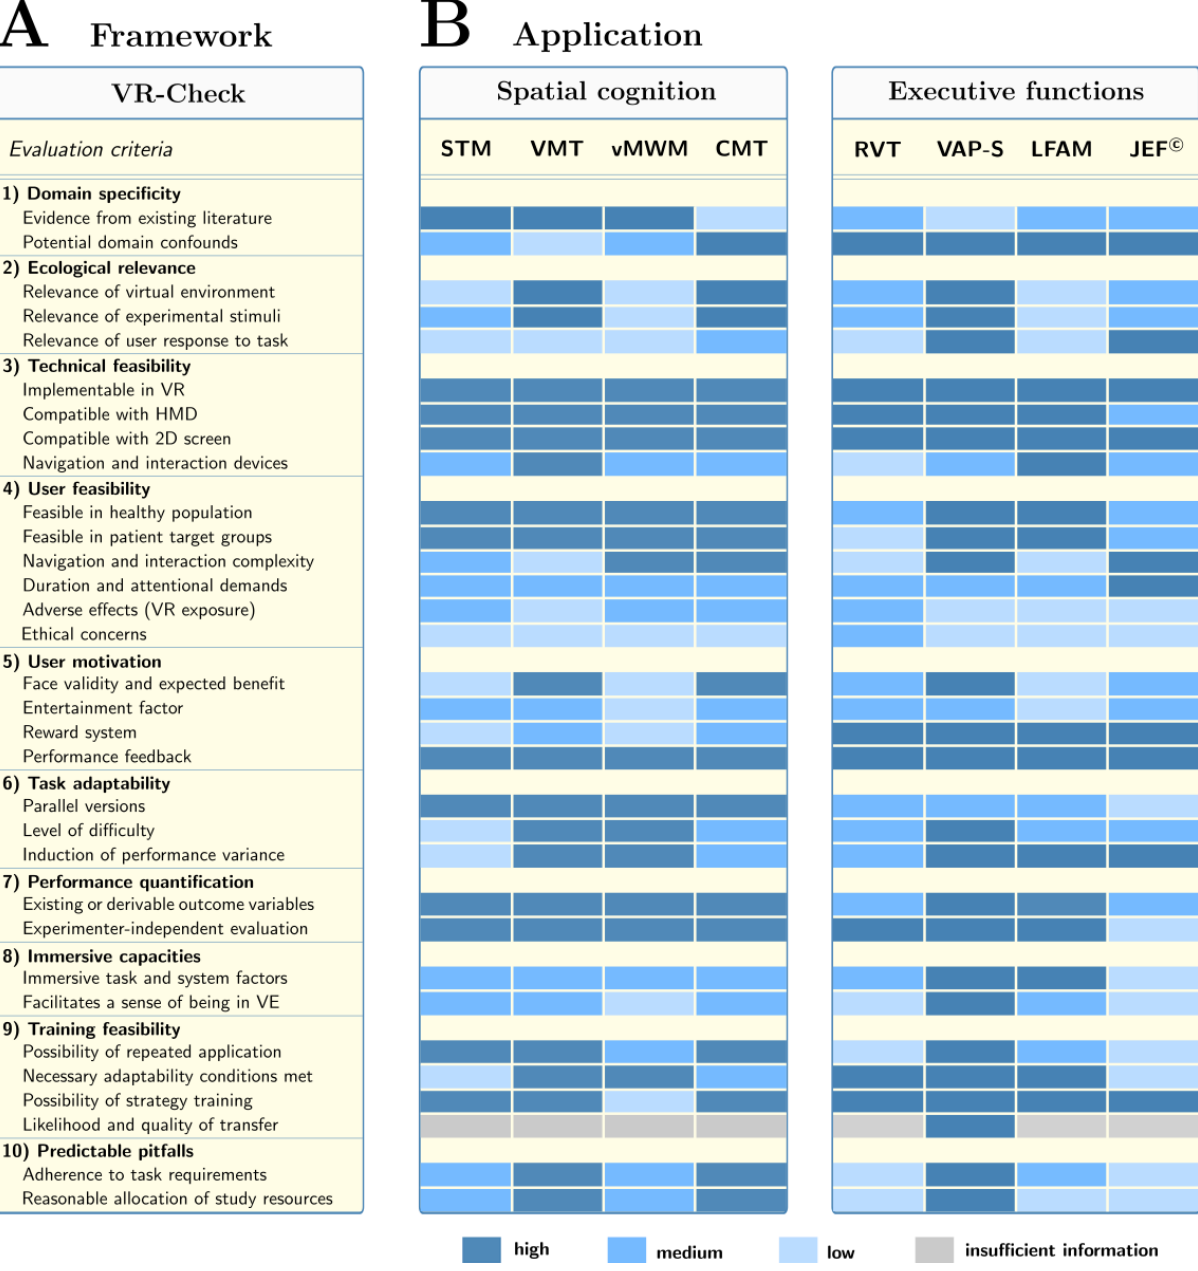
Figure 3. The VR-Check framework for virtual reality paradigms in neuropsychology. Panel A summarizes the evaluation dimensions in the form of a checklist. Panel B visualizes the application of the framework for the exemplary cases of assessing spatial cognition and executive functions with immersive VR. The color schemes display the item-wise consensus ratings on the degree to which the feature is fulfilled for a given paradigm. The evaluation procedure is illustrated for the Starmaze (STM), Virtual Memory Task (VMT), the Virtual Morris Water Maze (vMWM), and the Cognitive Map Test (CMT) for assessing spatial abilities, and the Ride in a Virtual Town (RVT), the Virtual Action Planning-Supermarket (VAP-S), the Look For A Match (LFAM) task as well as the Jansari assessment of Executive Functions (JEF) for assessing executive functions. For the given task requirements, the VMT, CMT, and the VAP-S emerged as the most suitable paradigms for the development of an immersive VR application, as detailed in the main text. 2D: 2-dimensional; HMD: head-mounted display; VE: virtual environment; VR: virtual